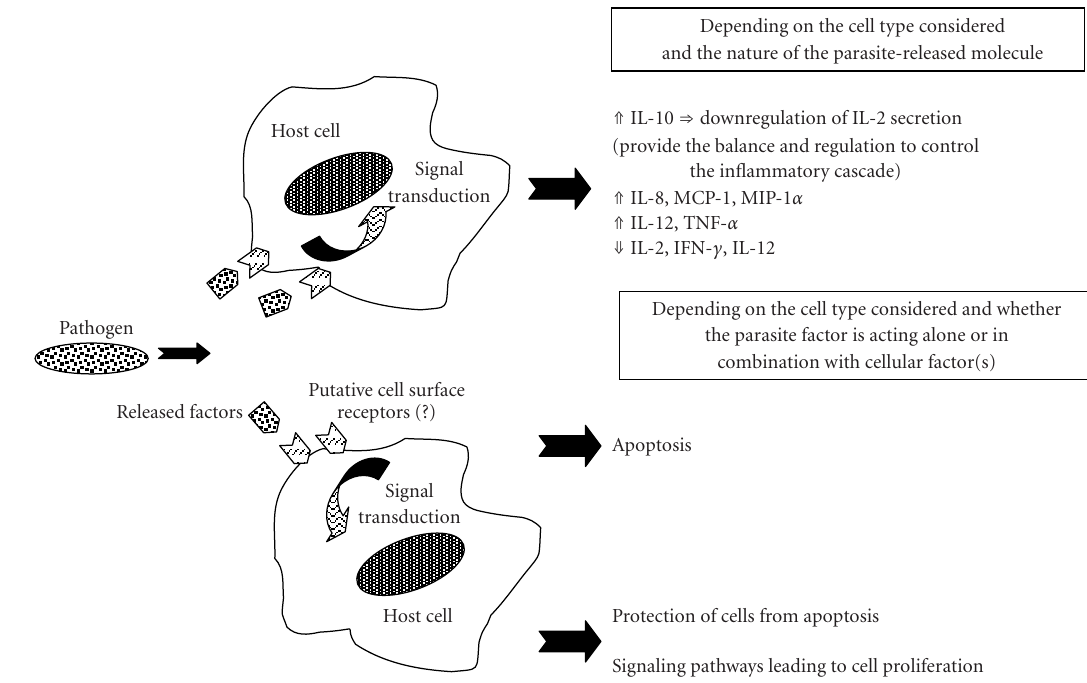
Figure 3. Schematic diagrams showing possible pathways by which the parasite-released factors a ff ect the immune